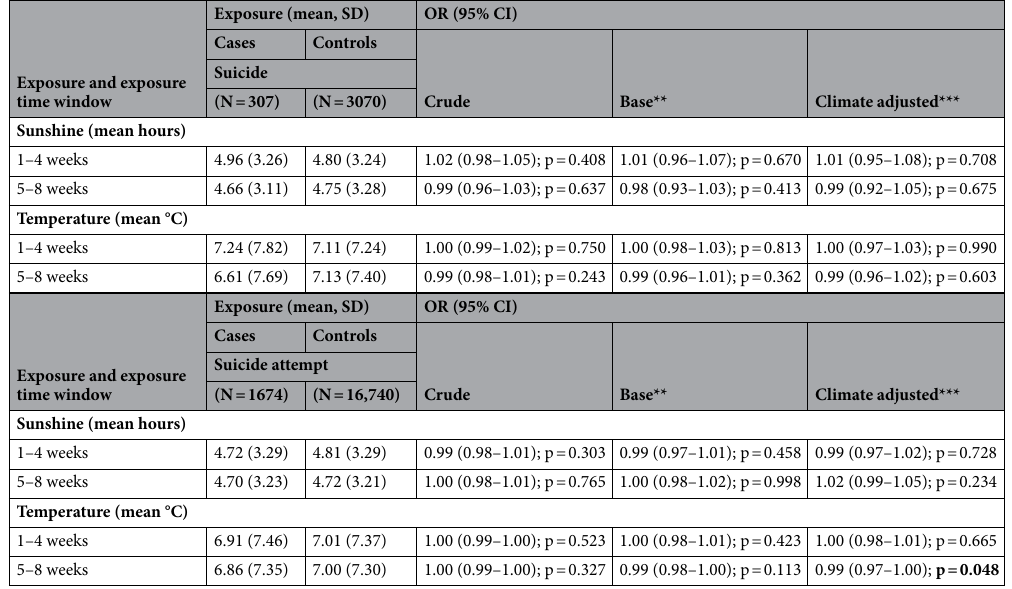
Table 2. Conditional logistic regression derived odds ratios (ORs) and 95% confidence intervals (95% CIs) for suicide and suicide attempt associated with sunshine hours and temperature during two exposure windows. Statistically significant result is given in bold. **Adjusted for previous suicide attempt, county, sex, age, year and season when the antidepressant treatment was initiated. ***Adjusted for all variables in Base model and temperature when sunshine was the exposure variable or sunshine when temperature was the exposure variable.